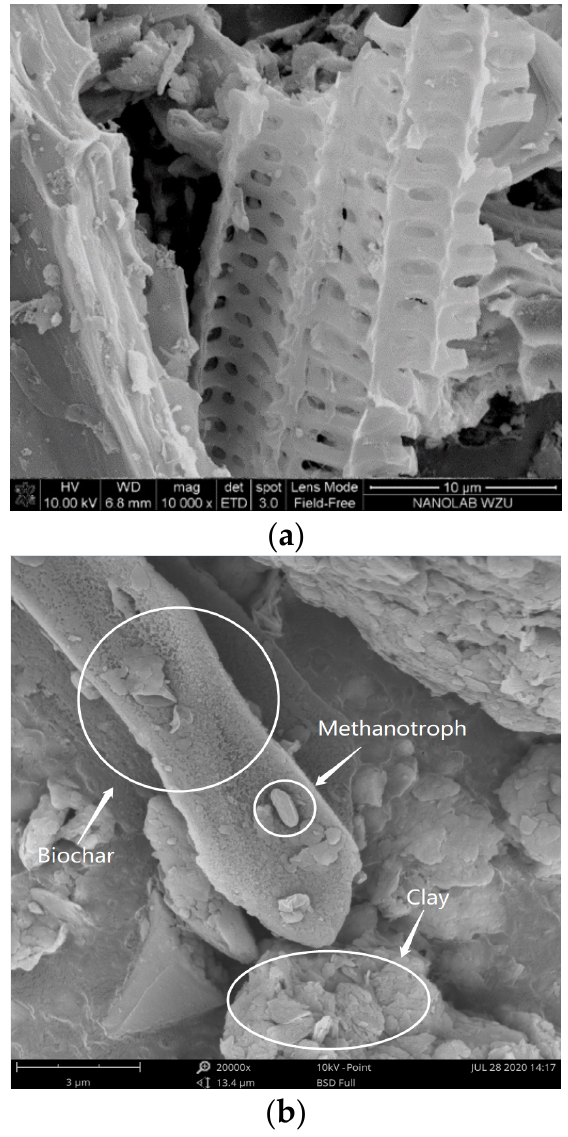
Figure 2. SEM images of biochar and biochar–clay mixture mixed with methanotrophs. ( a ) Morphological characteristics of the test biochar. ( b ) SEM images of biochar–clay mixture mixed with methanotrophs.